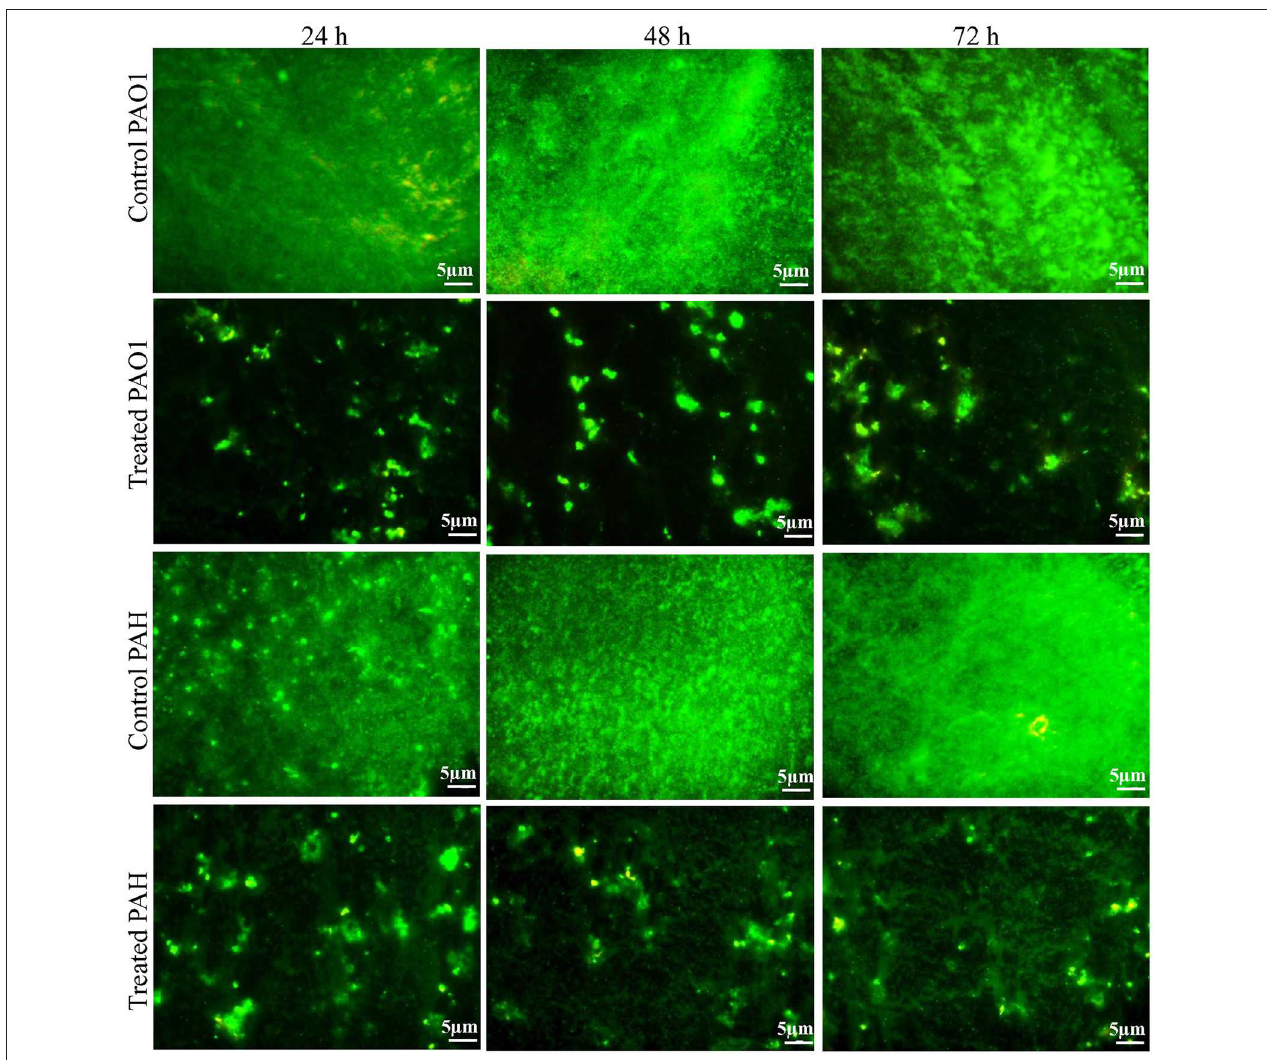
FIGURE 4 | Epi-fluorescence micrographs of biofilms developed by P. aeruginosa . The effect of the bacterial extract (0.1 mg/ml) on the viability of reference P. aeruginosa strains in the biofilm was examined at different time points (24, 48, and 72 h) and compared with control. The dead bacterial cells were labeled with propidium iodide whereas live cells stained with SYTO 9, which produced red and green fluorescence,